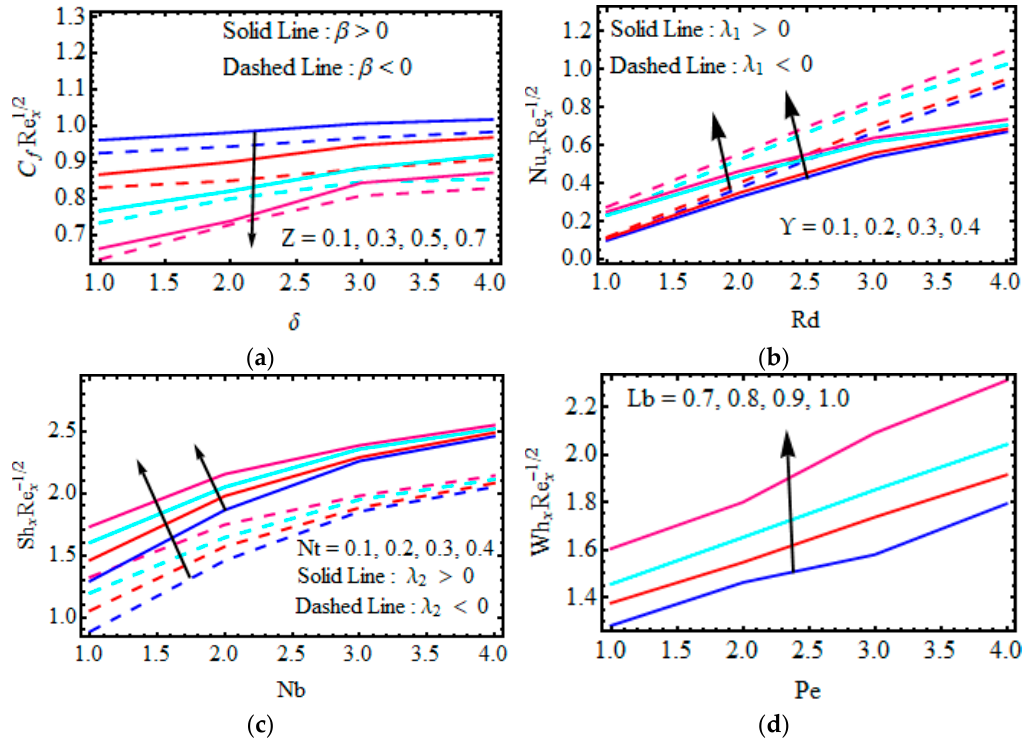
Figure 9. ( a – d ) Variation in the numerous variables of 𝑅𝑒 (cid:3051)(cid:2869)/(cid:2870) 𝐶 𝑓, 𝑅𝑒 (cid:3051)(cid:2879)(cid:2869)/(cid:2870) 𝑁𝑢, 𝑅𝑒 (cid:3051)(cid:2879)(cid:2869)/(cid:2870) 𝑆ℎ, 𝑅𝑒 (cid:3051)(cid:2879)(cid:2869)/(cid:2870) 𝑊ℎ (cid:3051) :